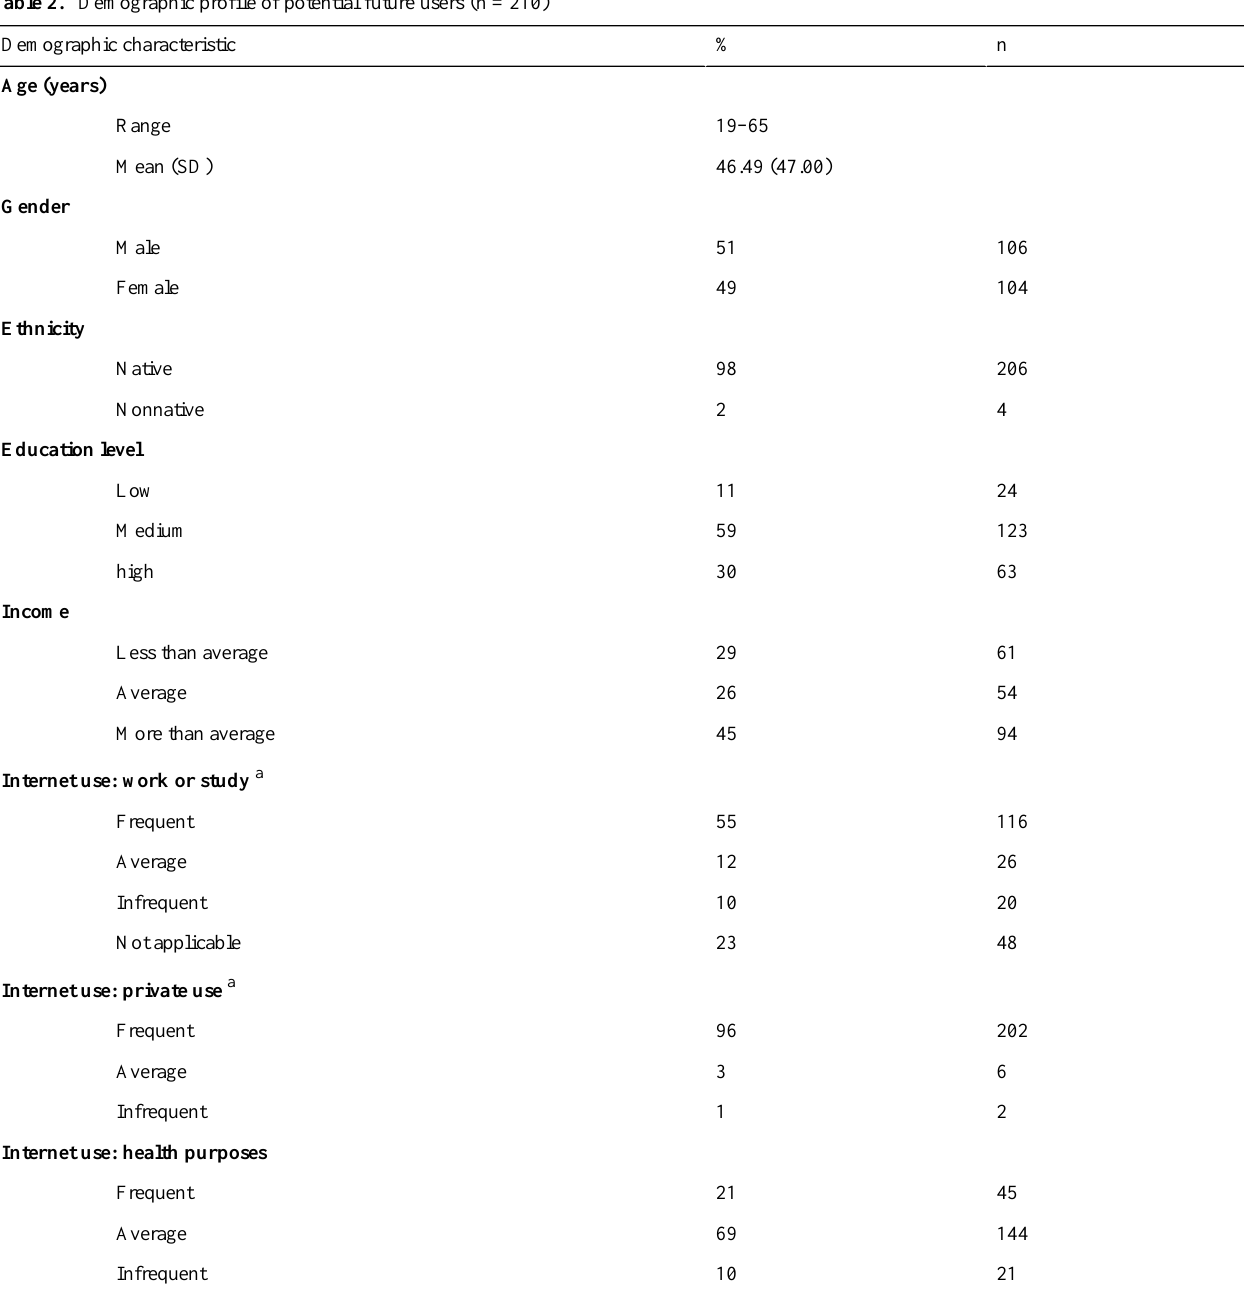
Table 2. Demographic profile of potential future users (n =